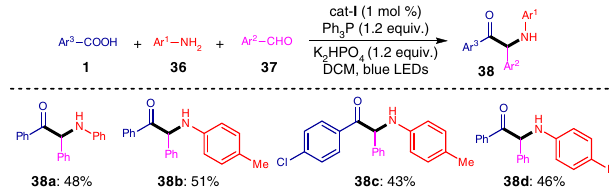
Fig. 9 A three-component reductive coupling reaction